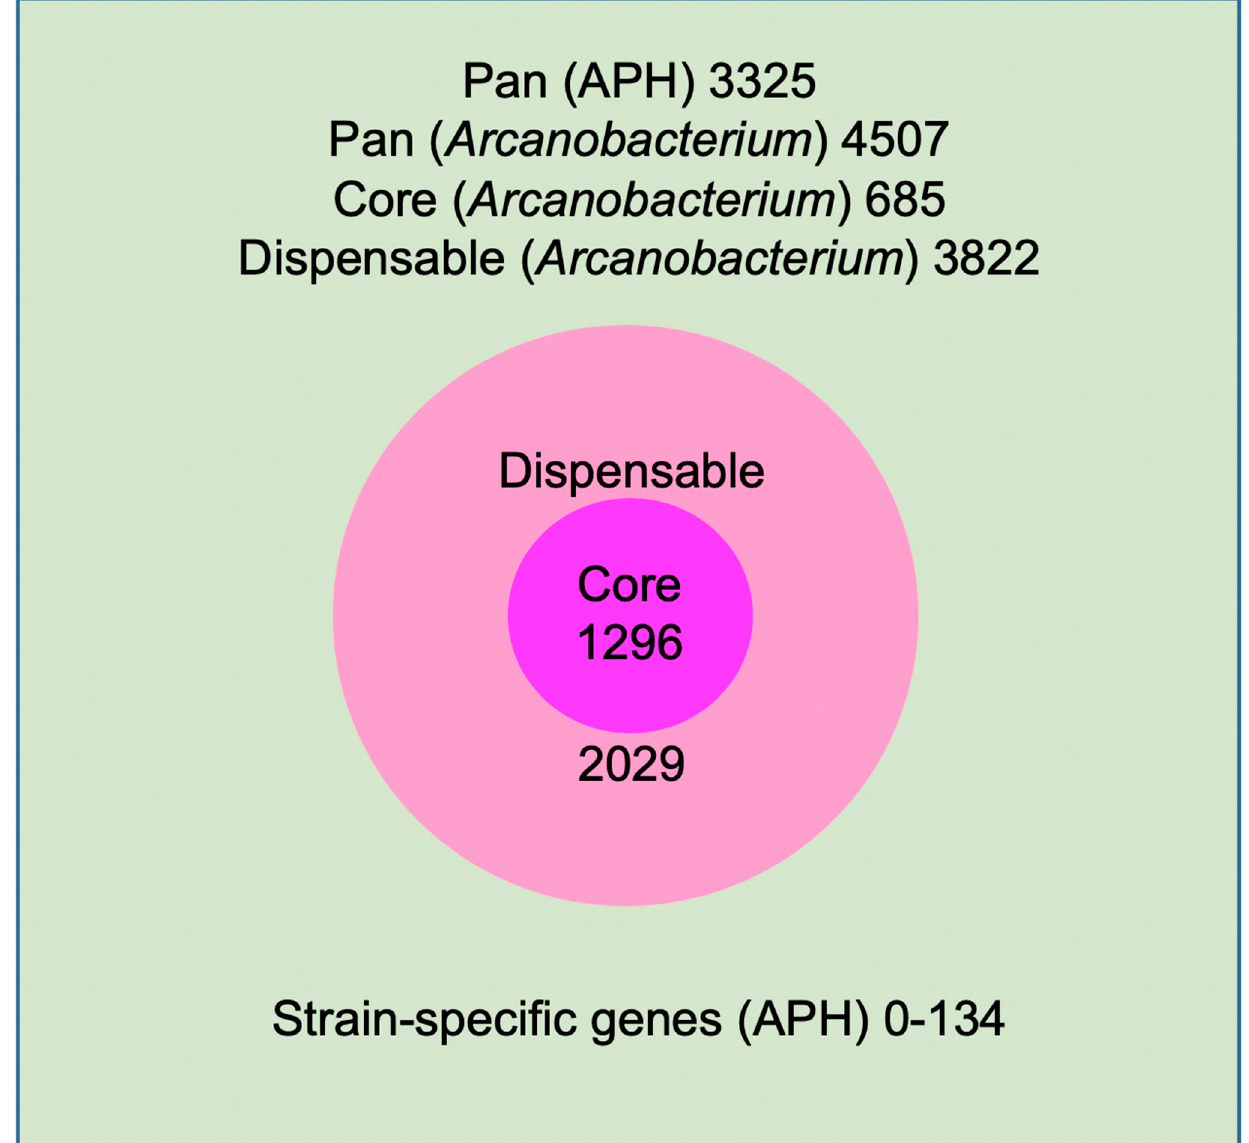
Figure 2. A. phocae pan-genome (3325 genes).